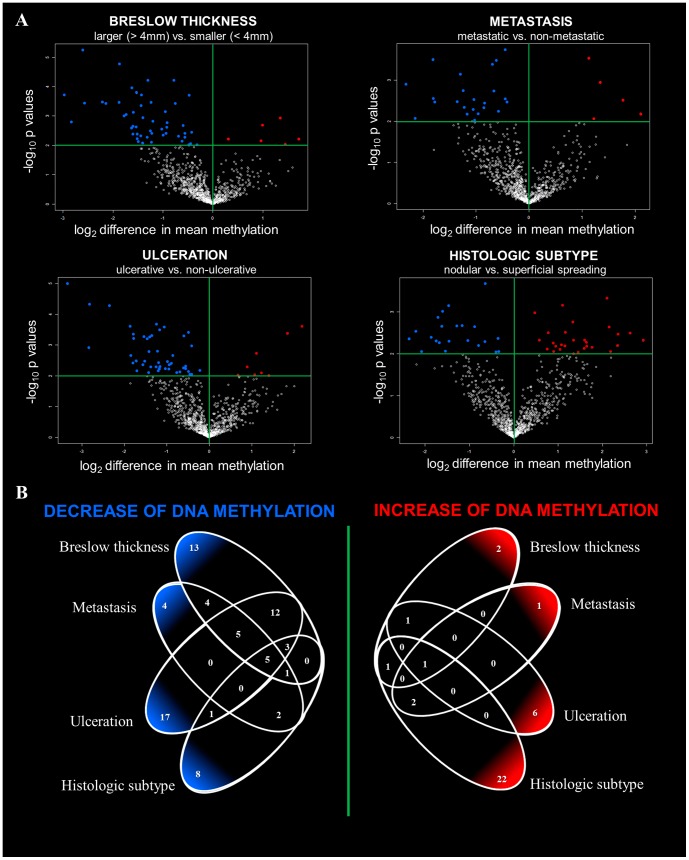
Methylation patterns of primary melanomas associated with known clinical predictors.(A) Volcano plots of differentially methylated genes associated with known predictors. Blue dots indicates decreased and red indicates increased methylation as follows: Breslow thickness: 51 hypomethylated probes (43 individual genes) and 5 hypermethylated probes (5 individual genes); metastatic capacity: 23 hypomethylated probes (21 individual genes) and 5 hypermethylated probes (4 individual genes), ulceration: 48 hypomethylated probes (43 individual genes) and 8 hypomethylated probes (8 individual genes), histologic subtype: 28 hypomethylated probes (26 individual genes) 23 hypermethylated probes (20 individual genes) (B) A Venn diagrams indicate the overlap of differentially methylated genes (in left: number of hypomethylated genes; in right: number of hypermethylated genes) for each clinical predictor class.